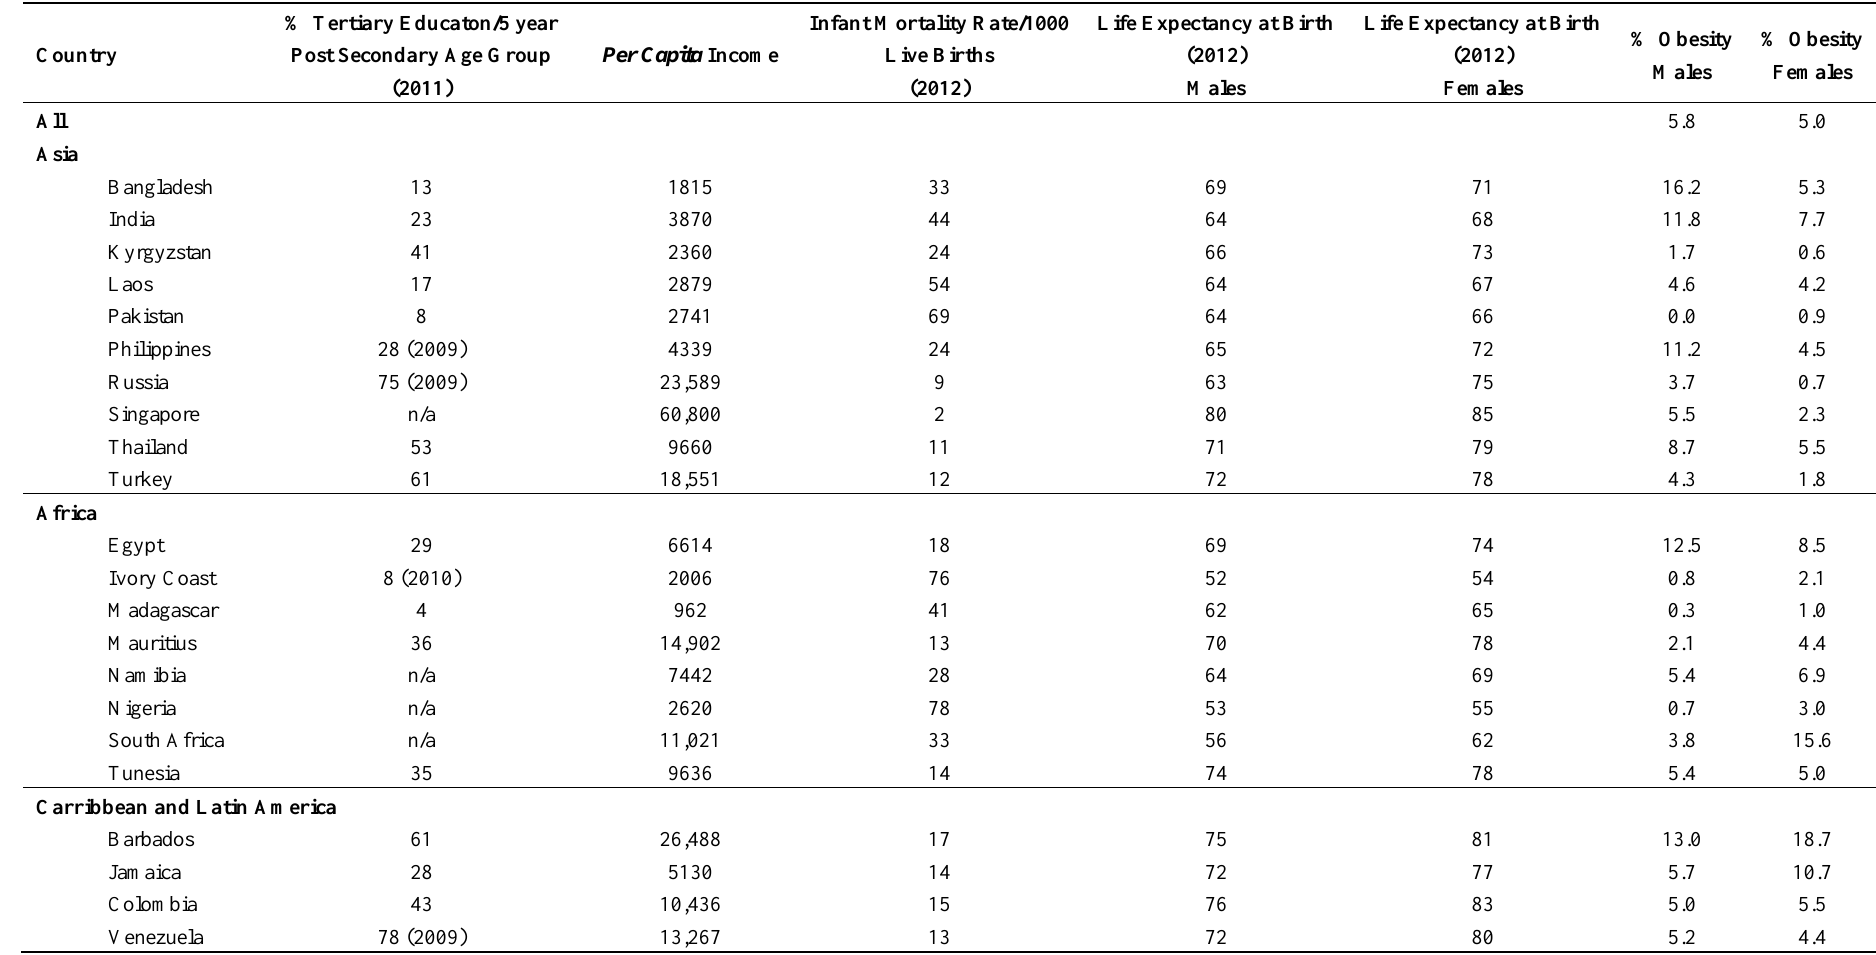
Table 5. Socio-economic profile and obesity prevalence of countries in